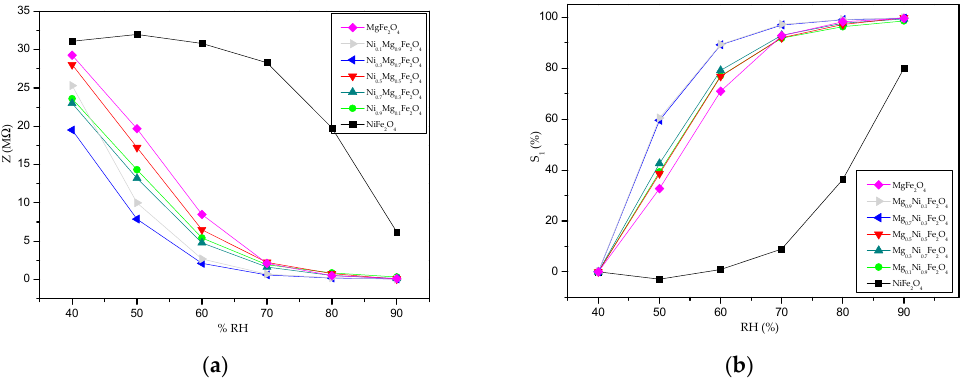
Figure 12. Impedance change with the relative humidity at 100 Hz for Ni x Mg 1-x Fe 2 O 4 ( a ); sensitivity change with relative humidity at 100 Hz ( b ).